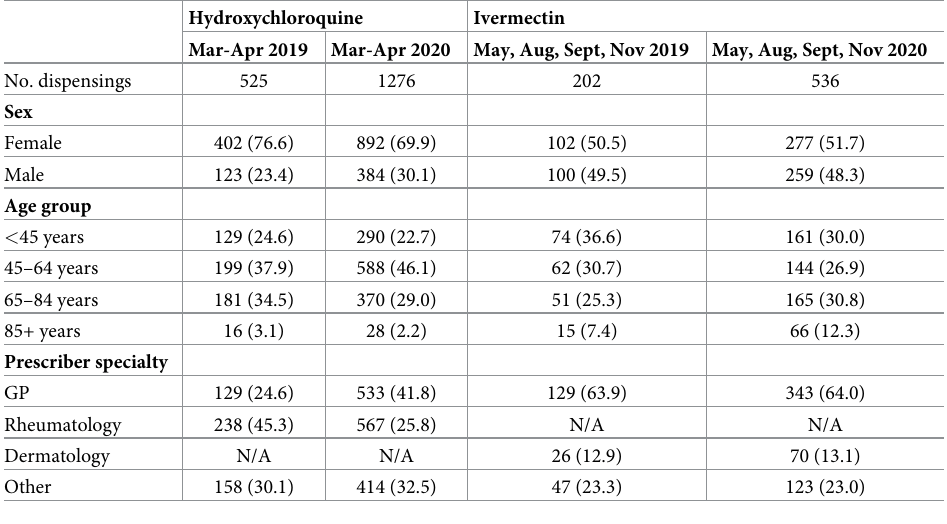
Table 3. People initiating hydroxychloroquine and ivermectin in months in 2020 where there was a greater than expected number of new users, compared with new users in 2019. Estimates are based on a 10% sample of PBS dis- pensing claims